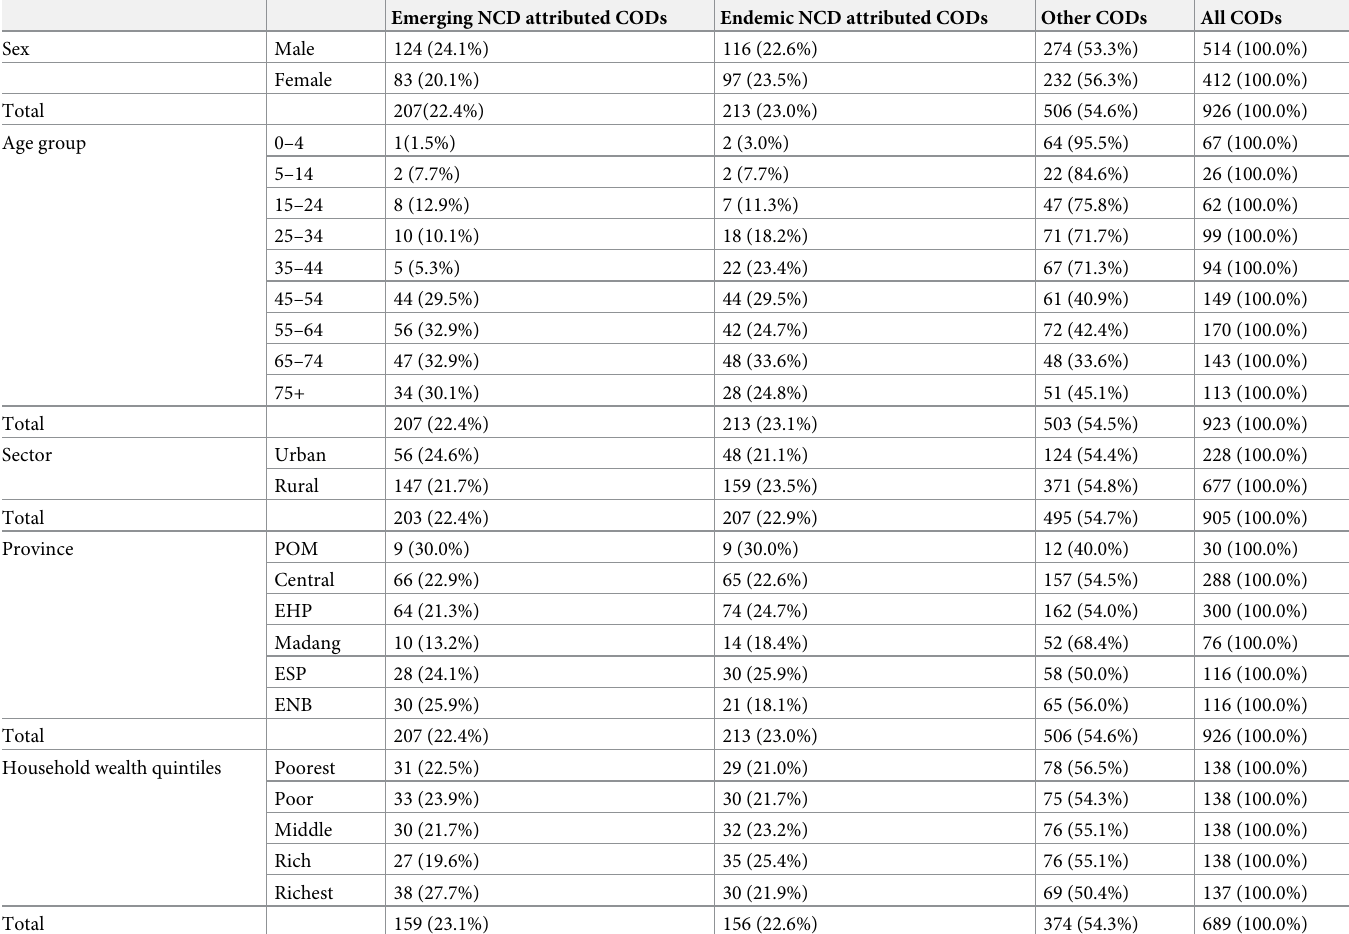
Table 1. Distribution of deaths attributed to emerging NCDs, endemic NCDs and other causes of death by sociodemographic characteristics of the deceased, PNGIMR’s CHESS